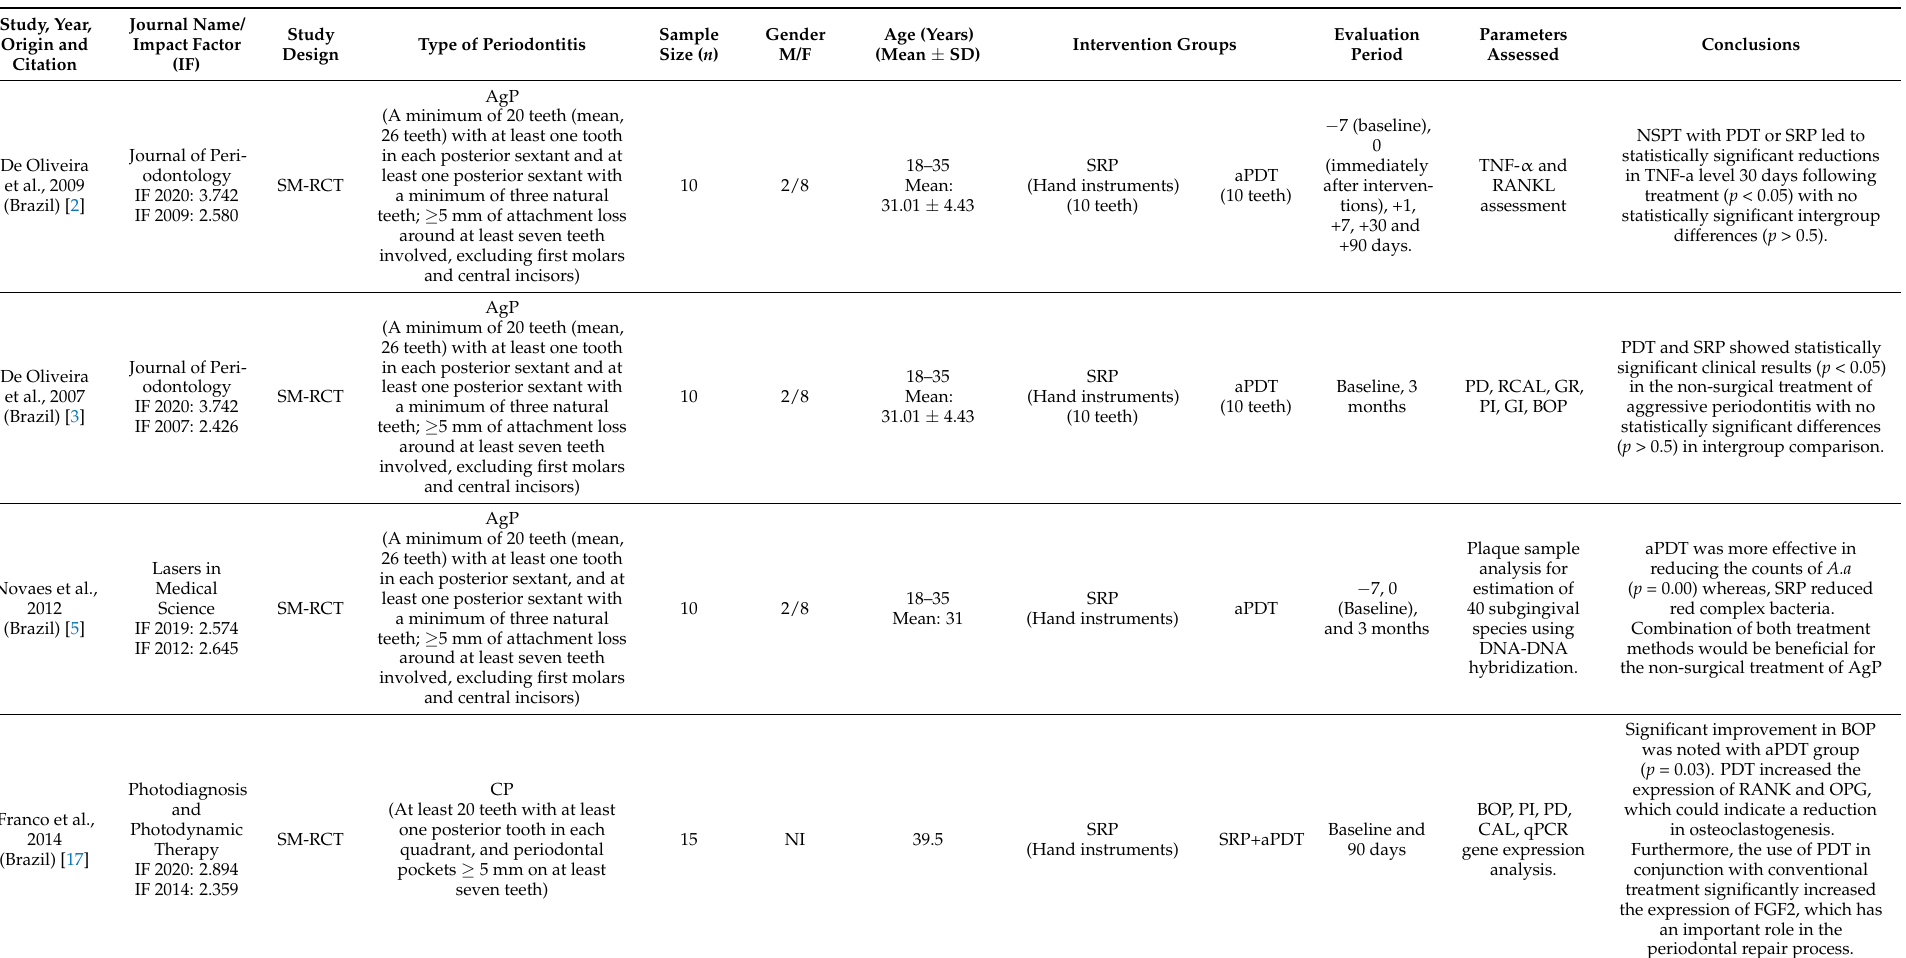
Table 1. Tabular representation of eligible in vivo human RCTs in terms of demography, study design, intervention groups, methods of assessment, evaluation period and outcomes. Refer to Supplementary file 2 for list of